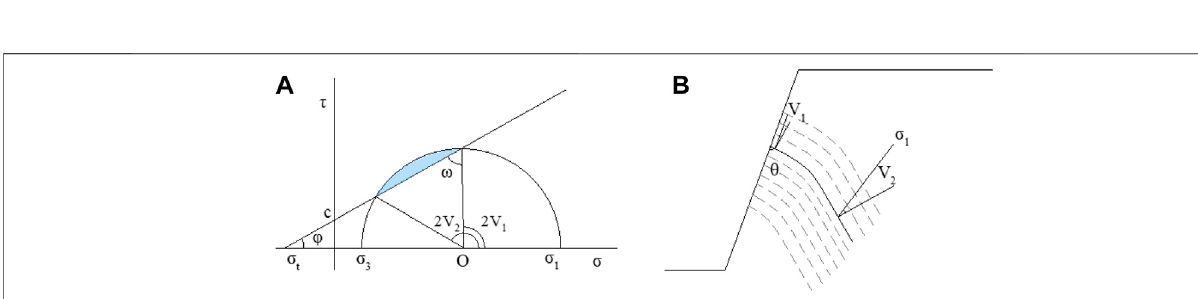
FIGURE 2 | Force system on elements of bending and toppling deformation slope: (A) toppling model; (B) elements.